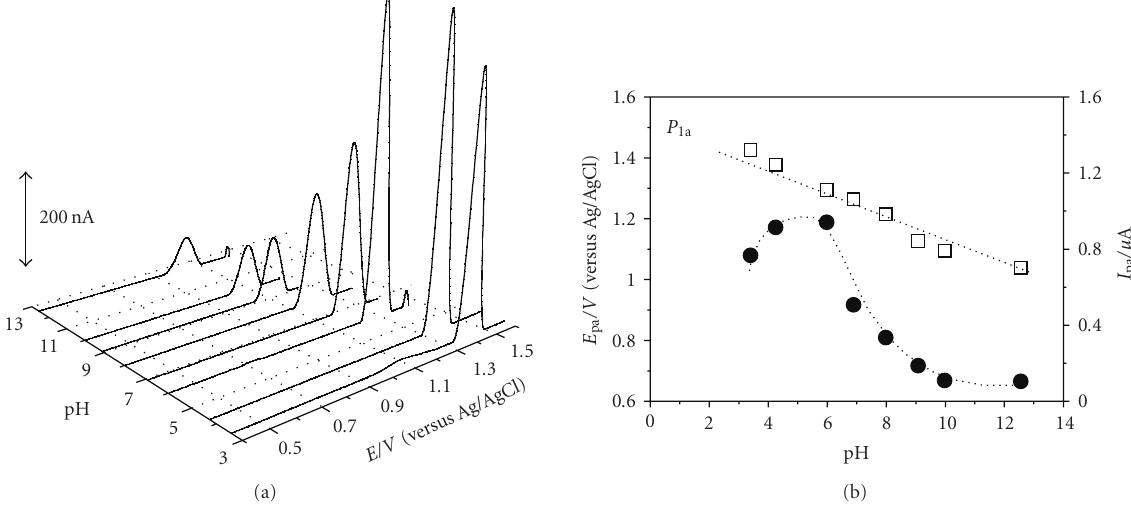
Figure 2: (a) 3D plots of baseline corrected DP voltammograms in 100 μ M FLU (b) Plot of peak 1 a : ( (cid:2) ) E pa and ( • ) I pa versus pH. Dotted line corresponds to 59 mV per pH